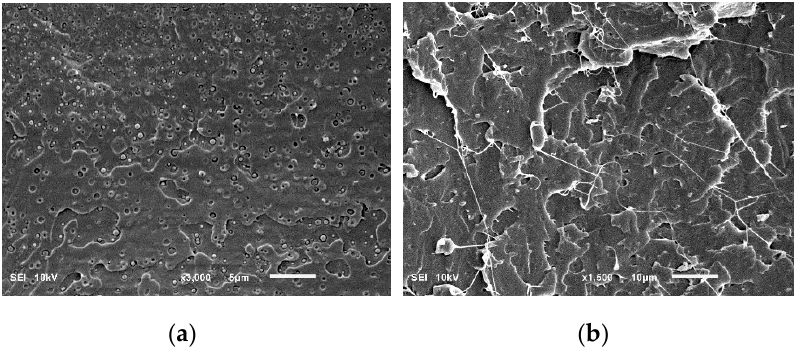
Figure 3. SEM images of cryofracture surfaces of polylactide (PLA) / PHA blends ( a ) and in situ generated composites ( b ).